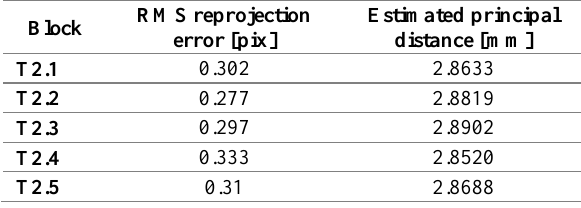
Table 4 – Photogrammetric blocks specifications of T2: